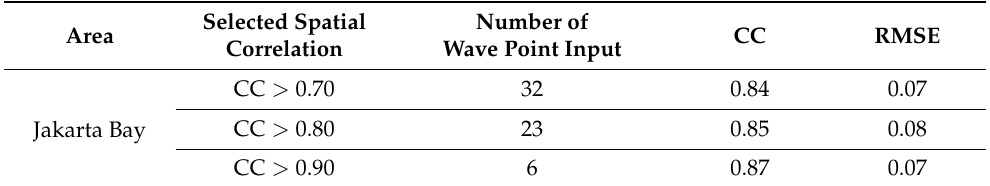
Table 3. Comparison between selected spatial correlation with results of downscaling performance for prediction 14 days ahead in Jakarta Bay area.